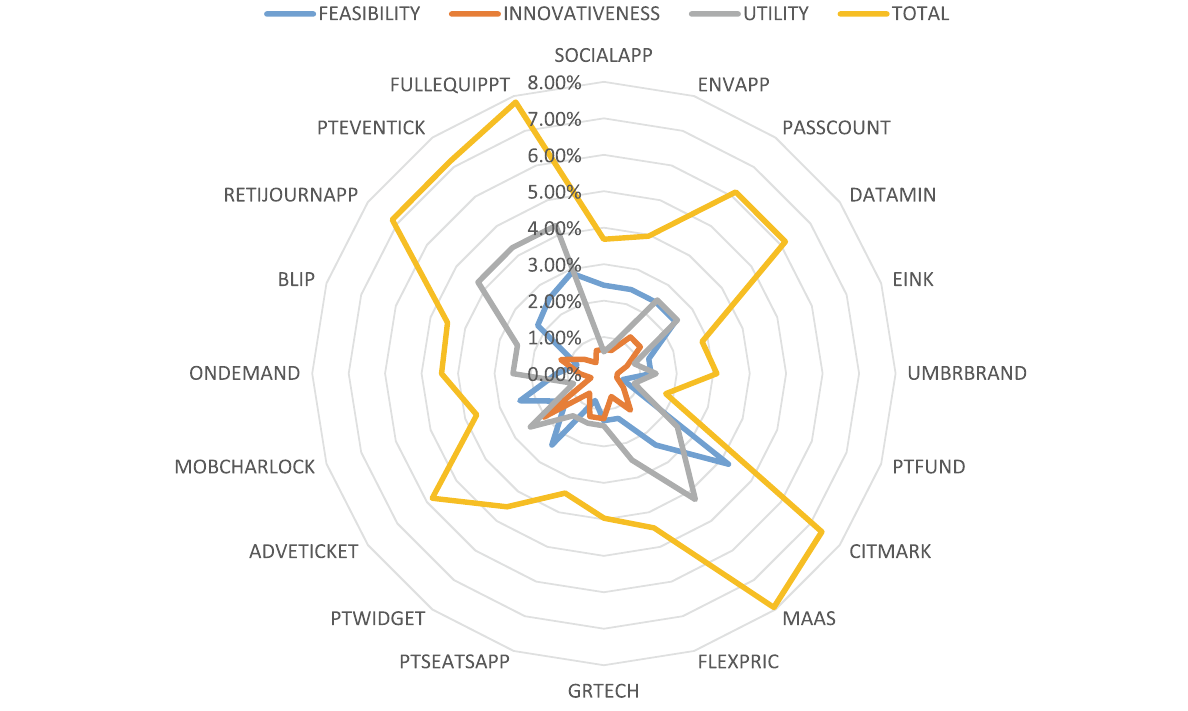
Fig. 8 Radar diagram with the evaluation scores of all the criteria per innovation (Normals